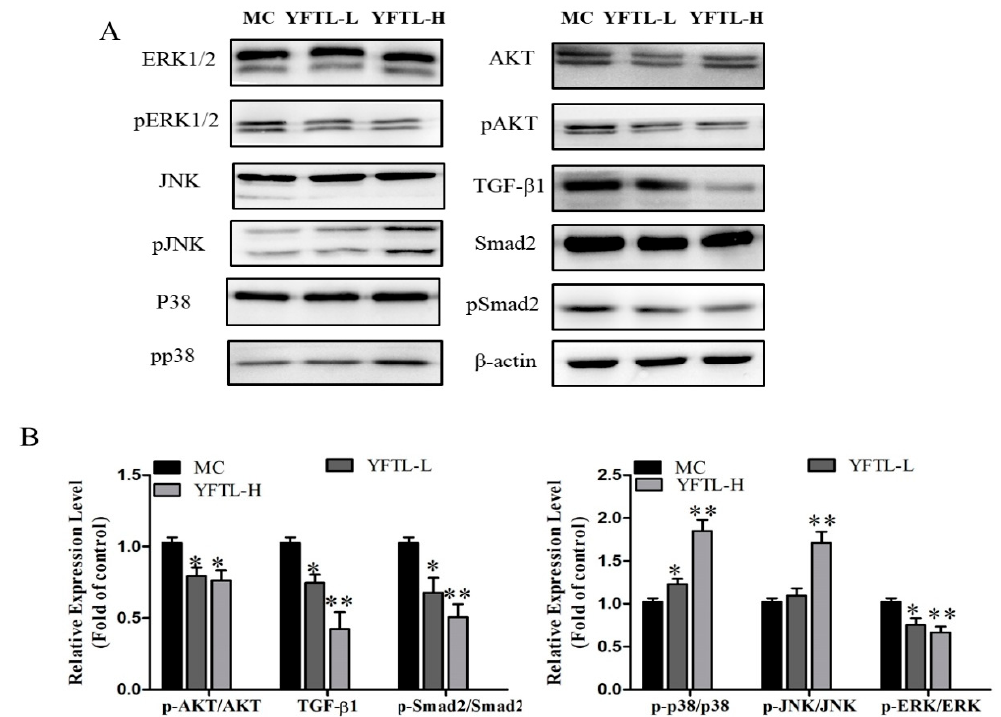
Figure 7. Regulation of PI3K/AKT, MAPK and TGF β /Smad2 pathways in YFTL treated Lewis tumor-bearing mice. Data are expressed as a histogram of mean ± SD of three independent experiments. * p < 0.05 and ** p < 0.01 vs. the MC group.